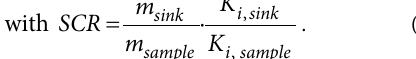
) partition constants OW ) partition coefficients without OC amorphous = 0.35K ) from Seth et al. OC OW